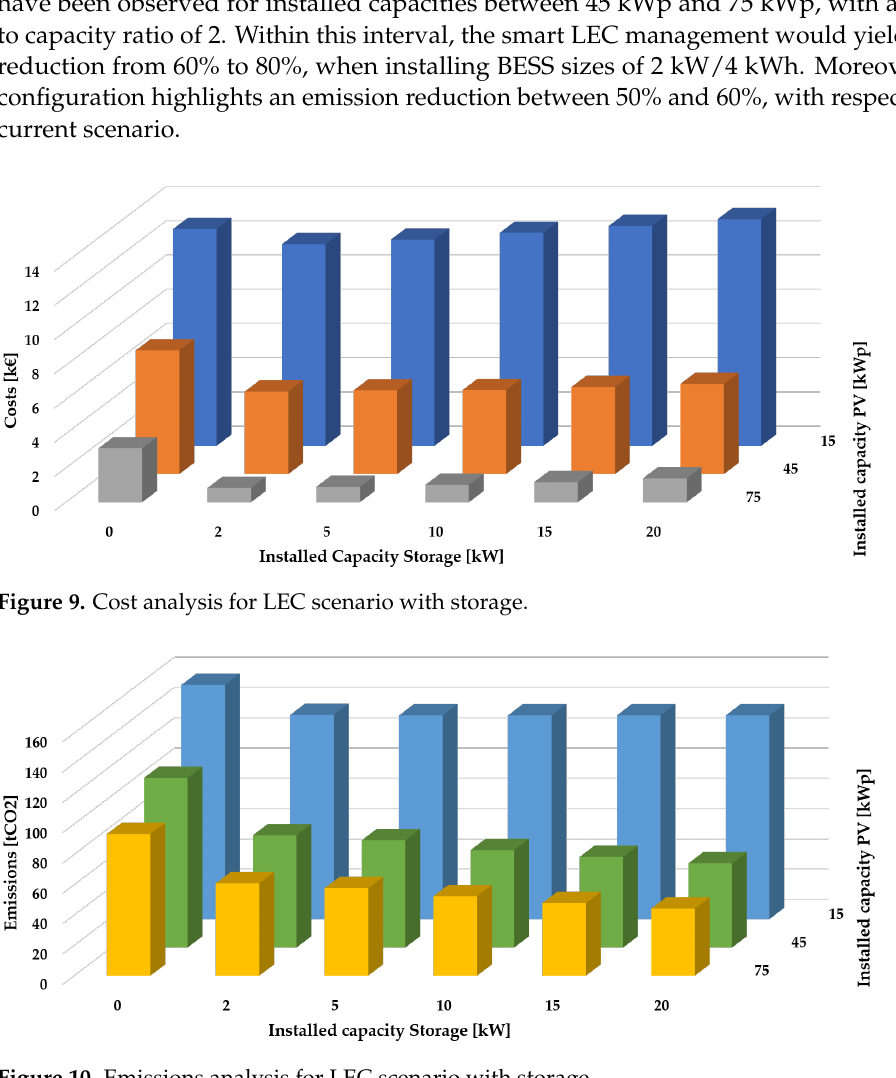
Figure 10. Emissions analysis for LEC scenario with